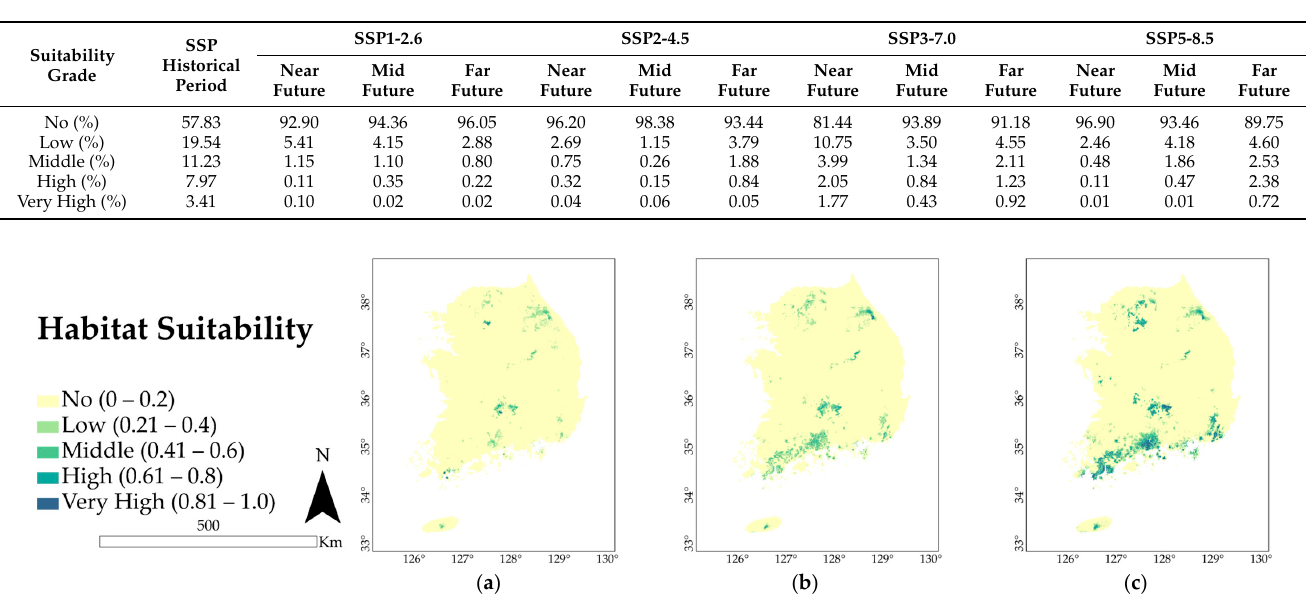
Table 3. The ratio of predicted area to total land area of South Korea for A. pictum under climate